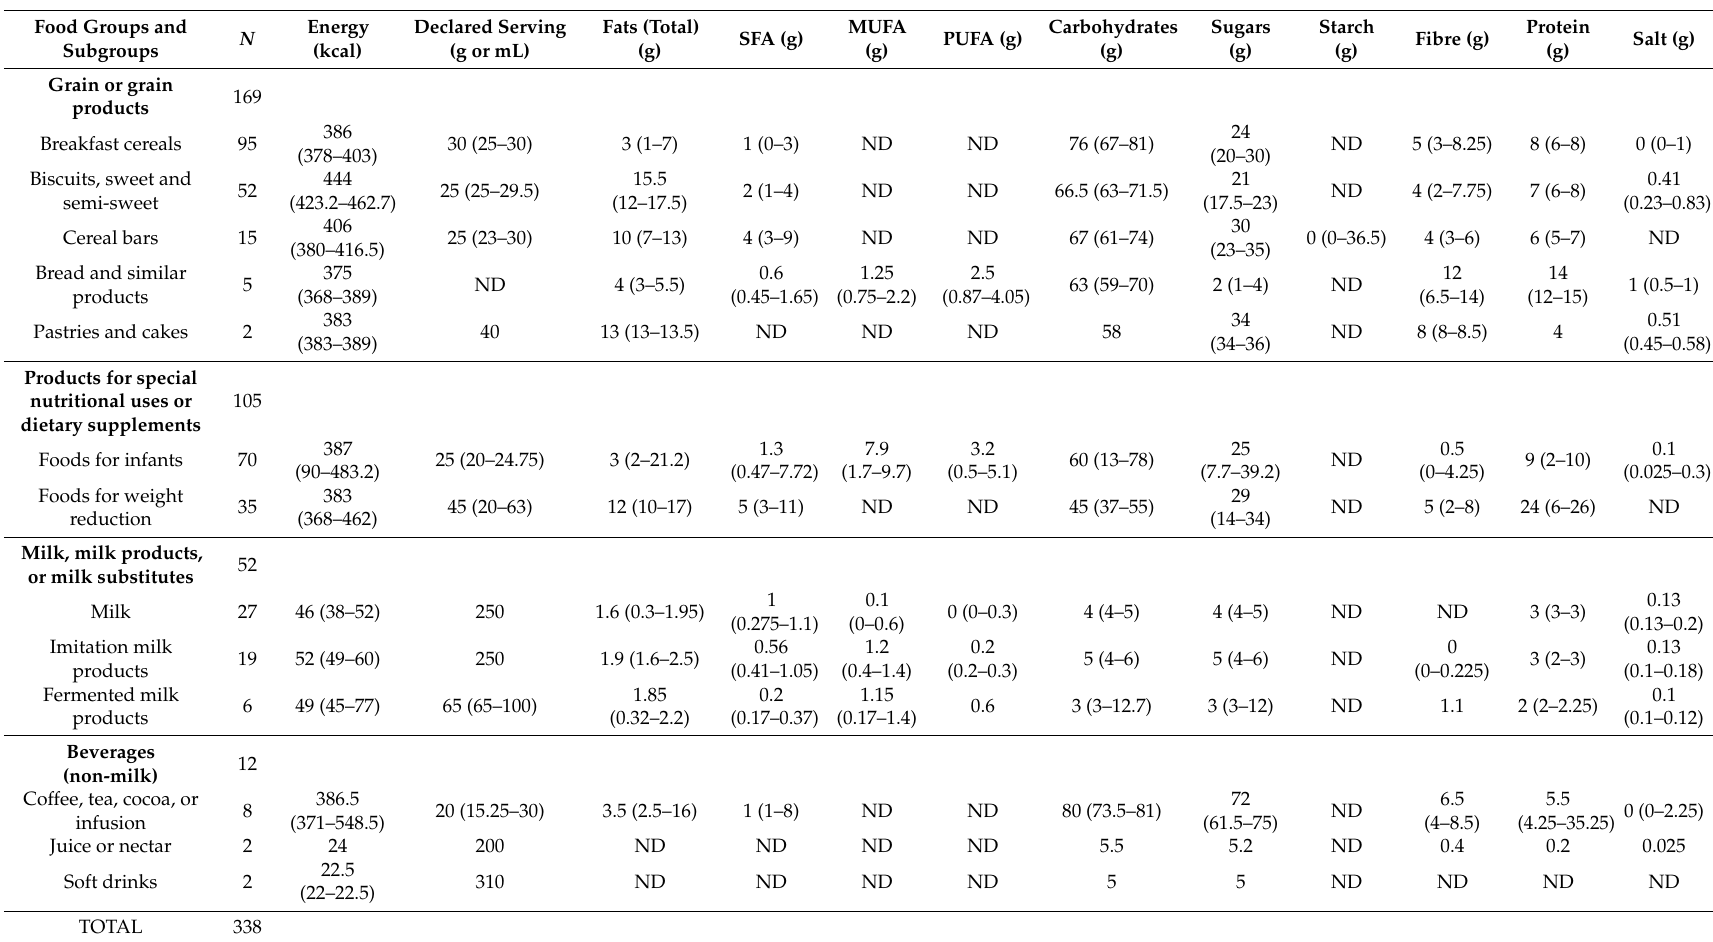
Table 1. Macronutrient distribution, fibre and salt content in folic acid-fortified food products from the Spanish